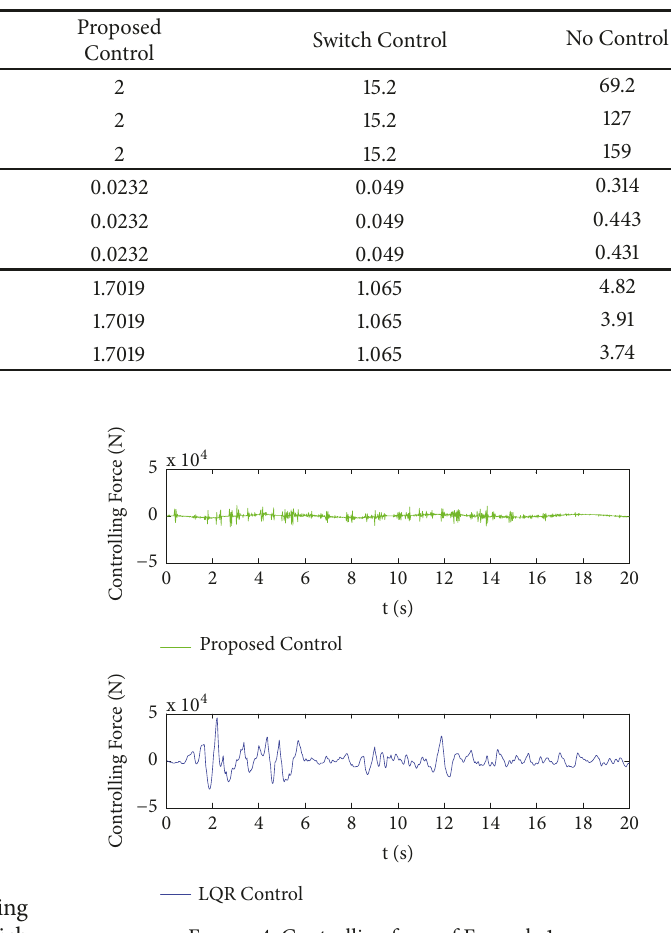
Figure 4: Controlling force of Example